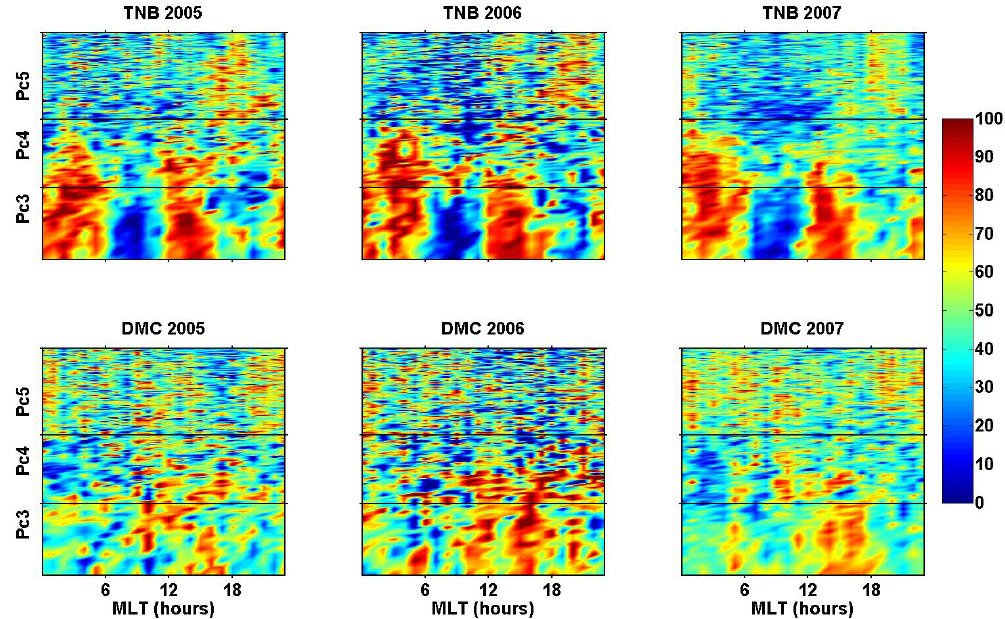
Fig. 7. MLT and frequency distribution of the percentage of CW events at DMC and TNB stations, separately for 2005, 2006 and 2007 summer months. Pc5, Pc4 and Pc3 labels indicate the band of frequency between the black horizontal lines on a log scale, i.e. 1–7mHz, 7–22mHz and 22–100mHz,